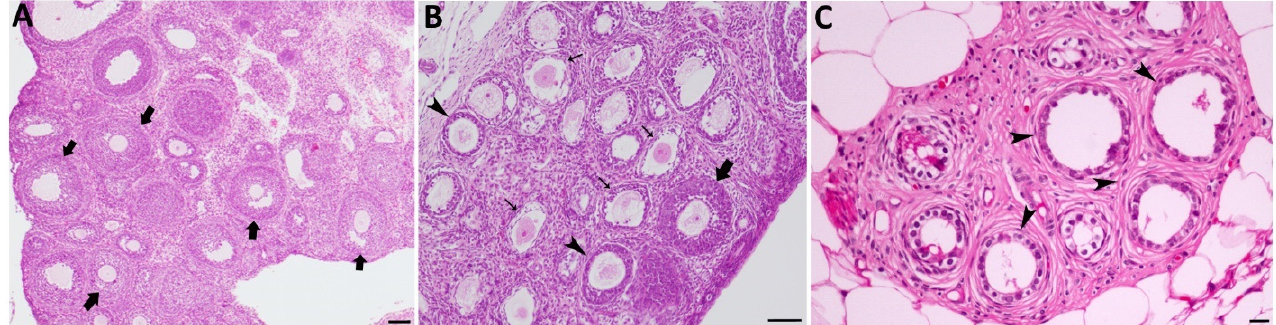
Figure 1. Allethrin exposure exerted toxic effects on ovarian function. Photomicrographs of ovarian sections from the control group ( A ) showed normal ovarian structures containing normal growing follicles (large arrows), whereas photomicrographs of allethrin-treated ovaries ( B ) showed altered structures in most of the growing follicles (arrows), as revealed by oocyte vacuolization and degra- dation, and this finding was obtained with both doses. Although few normal follicles were observed (large arrows), cystic dilation of follicles with decreased numbers of sparse granulosa cells was also observed with both exposure doses ( B , C ). Some of the ovaries from the higher dosage treated groups were reduced in size and contained cysts and degenerating follicles ( C ).